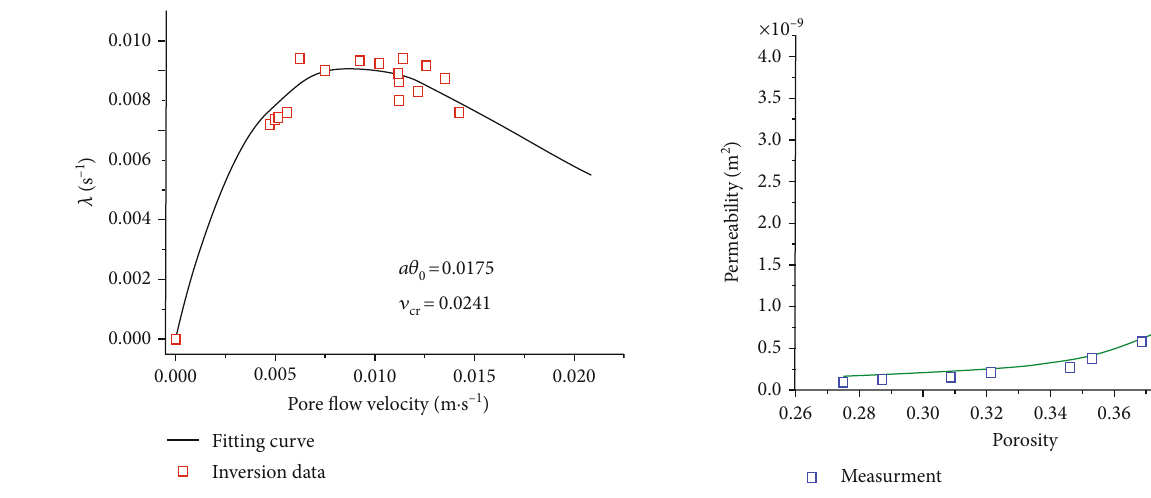
Figure 8: The nonlinear fi tting of inversion data ( WCR = 1 : 5 , Q = 2 : 85L/min